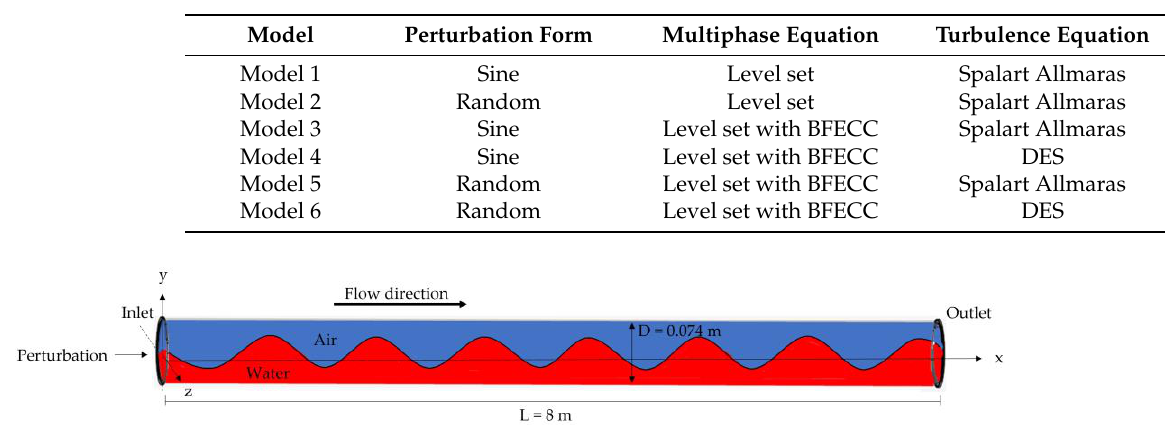
Table 2. Combinations of perturbations, multiphase and turbulence equations for each model.